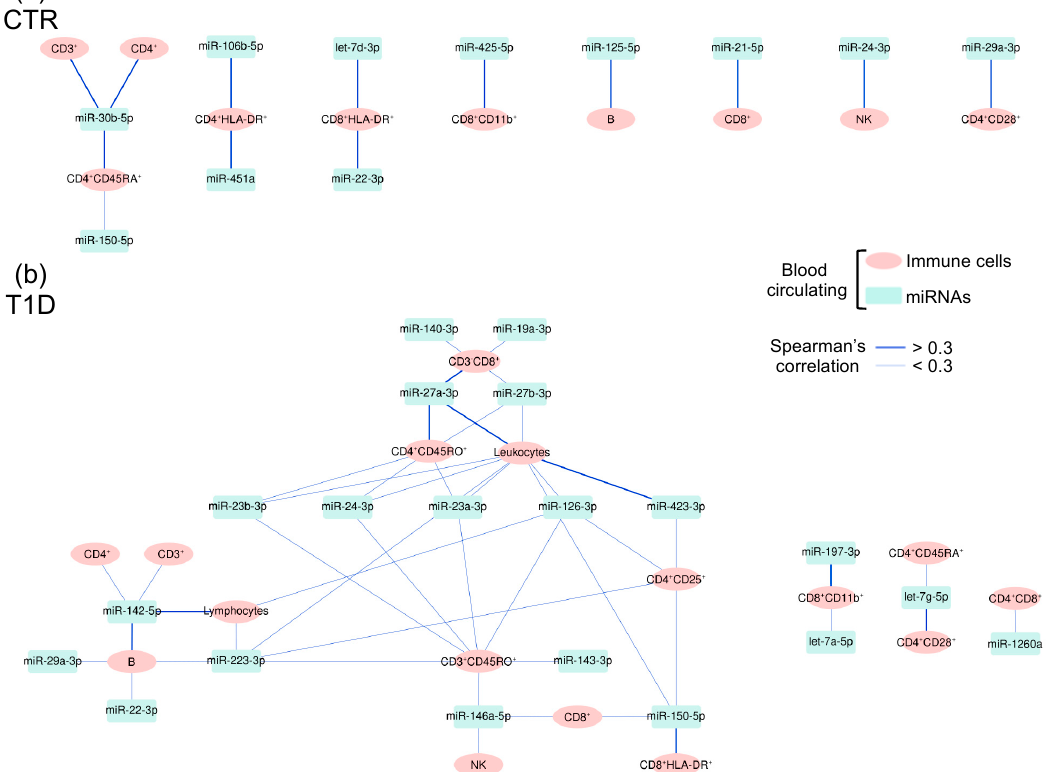
Figure 5. Correlation network between miRNAs and immune cells in healthy and T1D subjects. A positive correlation between the relative quantities of plasmatic miRNAs (green) and the absolute number/mm 3 of volume for peripheral blood circulating immune cells (pink) in CTR ( a ) and T1D children at diagnosis ( b ) is expressed by blue edges. Edge thickness expresses the level of Spearman’s correlation, r, as indicated. Neither miRNA–miRNA nor cell–cell correlations are reported.